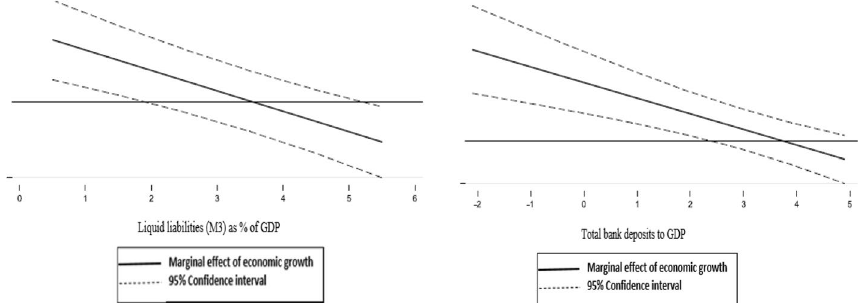
Fig. 9 Effects of economic growth (represented by scale effect, SE) on CO 2 emissions as financial development changes. Dependent variable: CO